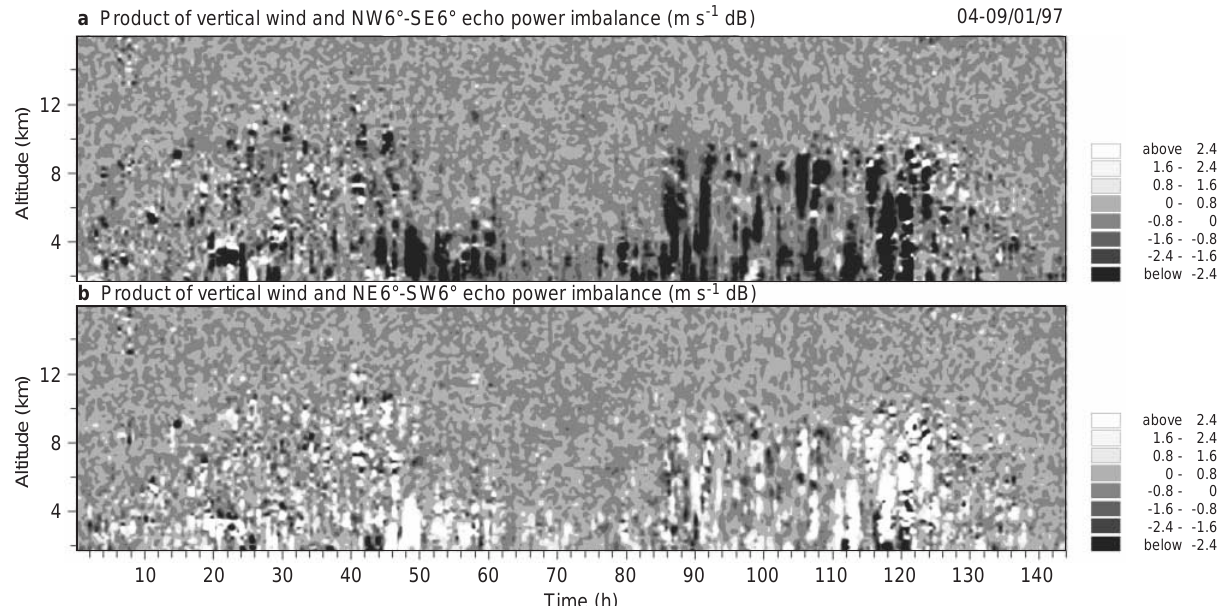
Fig. 5a ,b. Product of the vertical wind W and the power imbalances a ( P NW6 (cid:14) (cid:255) P SE6 (cid:14) ) and b ( P NE6 (cid:14) (cid:255) P SW6 (cid:14) ), before being converted into vectors for Fig. 4f